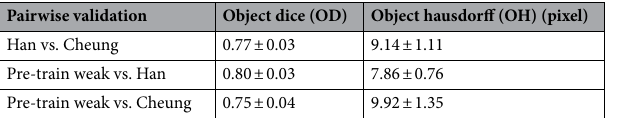
(Table 1). Specifically, for example, for ovarian cancer tissue datasets, the model was trained using samples from O-train and validated on O-test1 . Similarly, for breast cancer dataset, the model was trained using samples from B-train and validated on B-test . Our methods of pre-train weak and pre-train COCO were compared on our in- house datasets. The methods (i.e. pre-train weak , pre-train COCO and pre-train breast ) were compared to Micro- Net (state-of-the-art), and U-net using the public dataset. The models were trained with samples from M-train and validated on M-test . The direct comparison to Micro-Net and U-net can be found when using a training sample size of 72 ROIs, which is the sample size Shan et al. 19 used in their study. Error metrics. Object-Dice (OD) and object-Hausdorff (OH) were computed as metrics to measure the sys- tem performance 37 . The Dice coefficient 38 measures how well the segmented region matches the ground truth. Hausdorff distance 39 measures the longest distance between the segmentation boundary and the ground truth